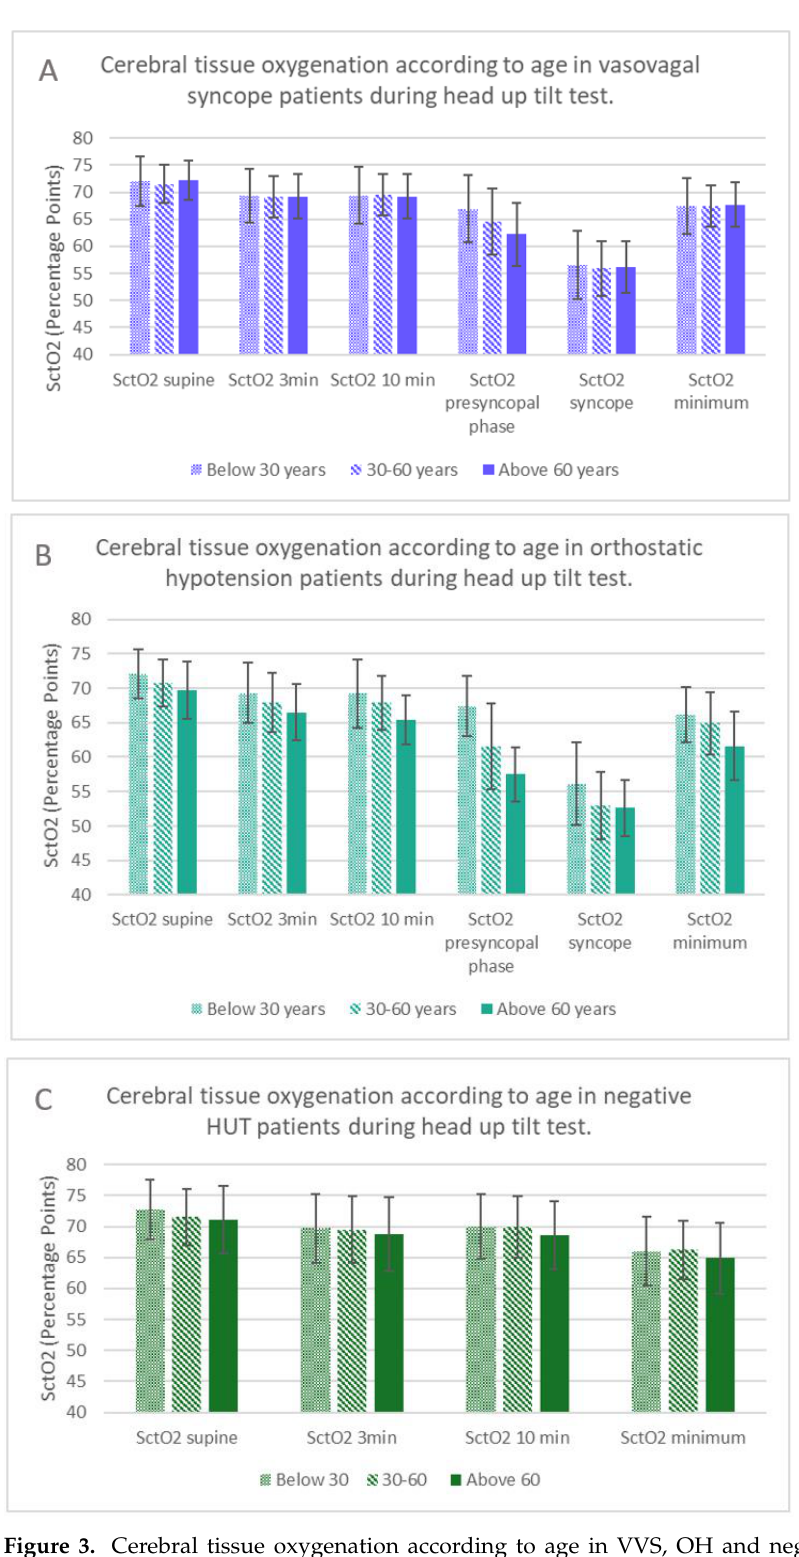
Figure 3. Cerebral tissue oxygenation according to age in VVS, OH and negative head-up tilt tests. ( A ). SctO2 during HUT in VVS. ( B ). SctO2 during HUT in OH. ( C ). SctO2 during HUT in patients with negative HUT. Abbreviations: HUT = head-up tilt test; OH = orthostatic hypotension; SctO2 = cerebral tissue oxygenation; VVS = vasovagal